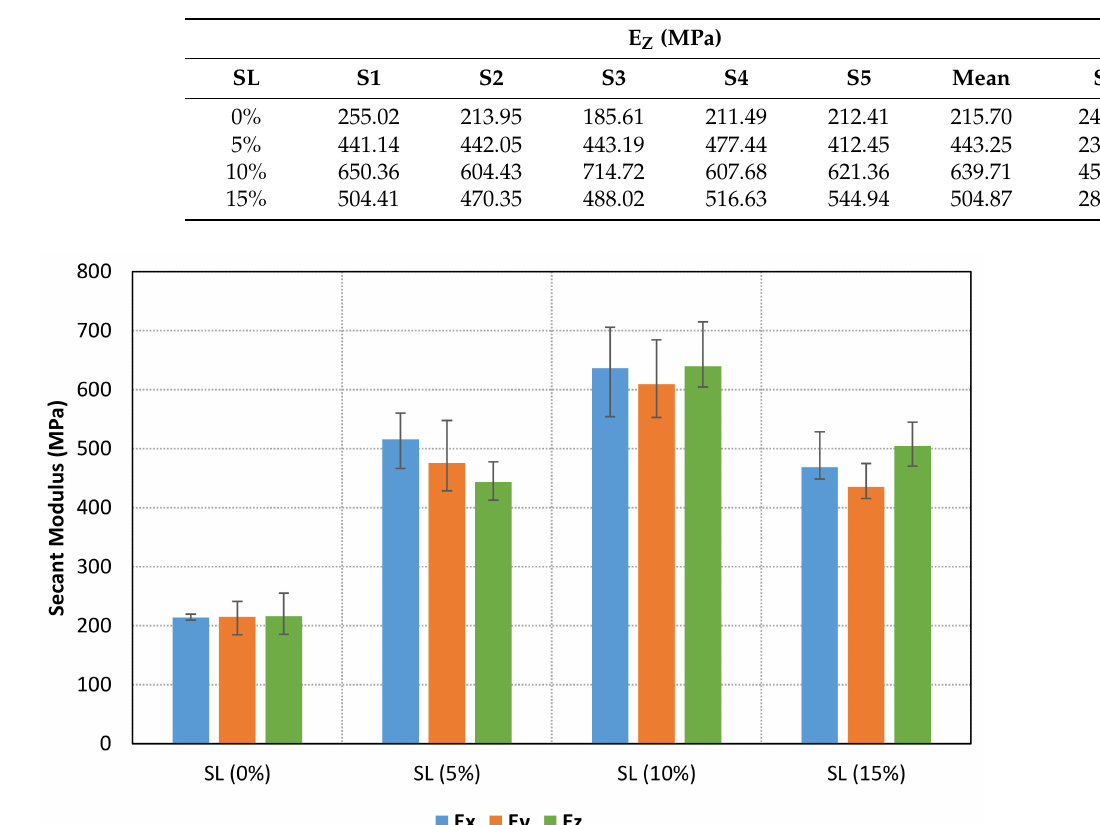
Table 5. Secant modulus (MPa) for Z samples.